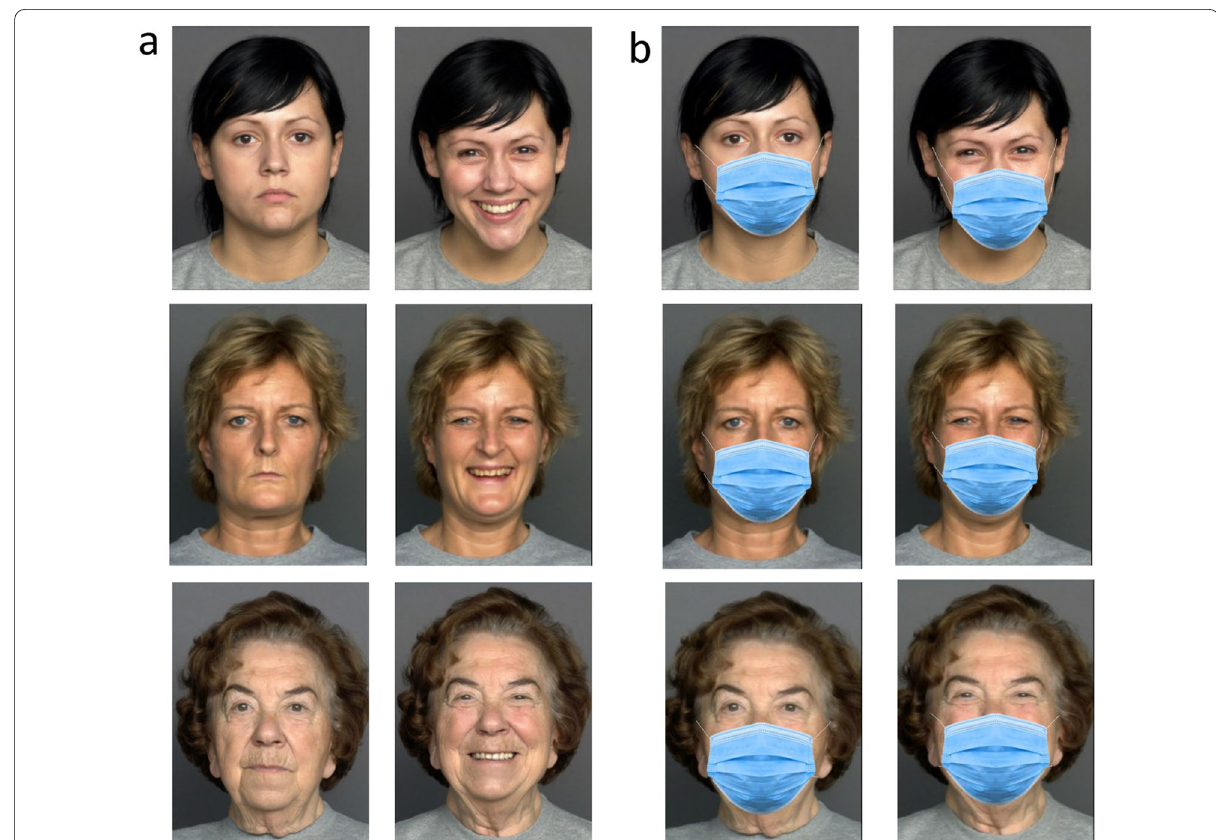
Fig. 1 Sample of the stimuli used in Experiments 1 and 2. a Unmasked neutral and smiling faces of young adults, middle-aged adults, and old adults. b Masked versions of the same faces. The unmasked faces were adapted from Ebner, N. C., Riediger, M., & Lindenberger, U. (2010). FACES—A database of facial expressions in young, middle-aged, and older women and men: Development and validation. Behavior Research Methods, 42, 351–362. https:// doi. org/ 10. 3758/ BRM. 42.1. 351, all rights